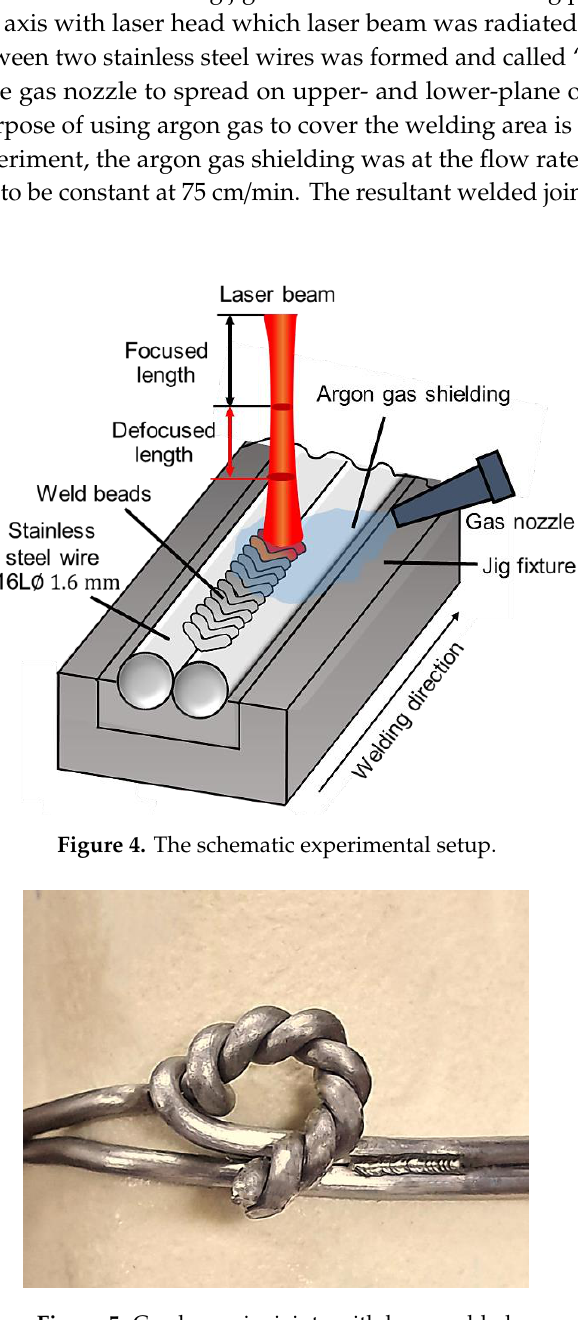
Figure 5. Cerclage wire joints with laser welded.